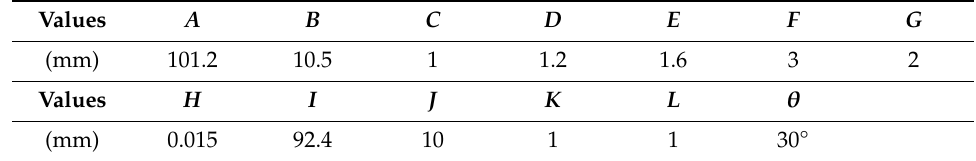
Table 1. Geometric boundaries of UHF I-RFID tag antennas.